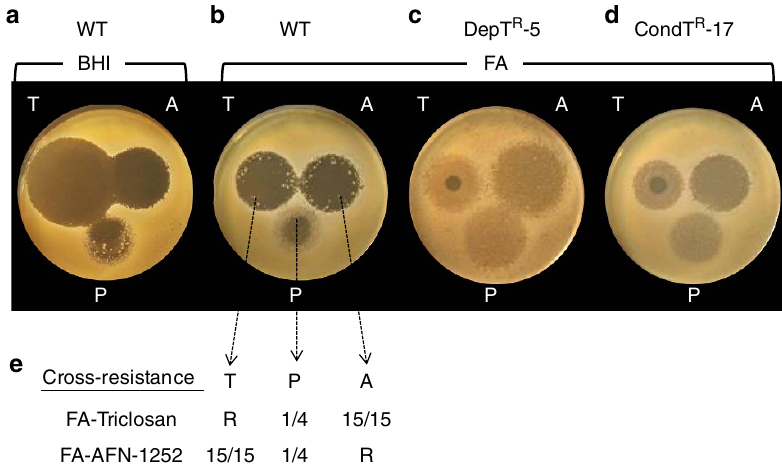
Figure 5 | S. aureus cross-resistance to anti-FASII drugs in the presence of exogenous fatty acids. Overnight BHI-FA-grown cultures of Newman WT, DepT R -5, and CondT R -17 were washed twice in BHI and plated on BHI solid medium without ( a ) (for Newman strain) or with fatty acids ( b – d ). Plates were spotted with triclosan (‘T’, 1.5 m g), AFN-1252 (‘A’, 1 m g), and platensimycin (‘P’, 8 m g), respectively 100, 100 and 16 times the MIC. Photographs were taken after 48h at 37 (cid:2) C. ( c ) DepT R -5 and ( d ) CondT R -17 strains accrue resistance to all three drugs on FA plates as seen by growth within the halo region, as compared with ( b ) the WTstrain. The small inhibitory zone around triclosan is attributed to non-specific membrane effects 12 . ( e ) colonies that appeared within the inhibitory zones of WT strains on BHI-FA plates were cross-patched on BHI, BHI-FA, BHI-FA-AFN-1252 (80ngml (cid:2) 1 ) and FA-triclosan (250ngml (cid:2) 1 ). All colonies picked in fatty acids as triclosan-resistant were AFN-1252-resistant, and conversely. Fatty acid profiles (not shown) determined for colonies from each anti-FASII selective plate were fully